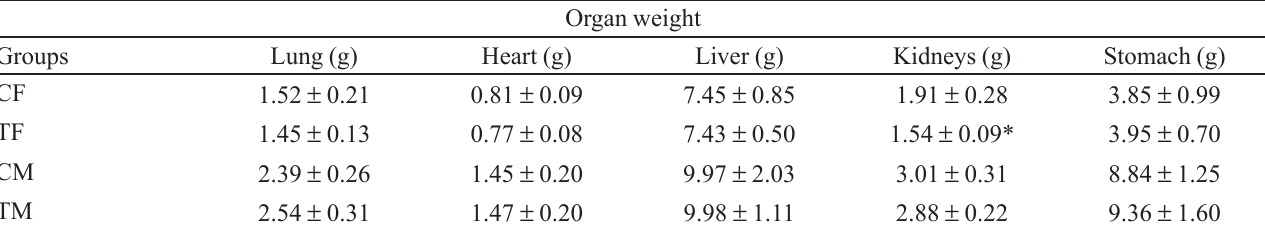
TABLE II - Changes in organ weight of rats after subchronic oral treatment with atranorin (ATR) at a daily dose of 50 mg/kg for 30 days